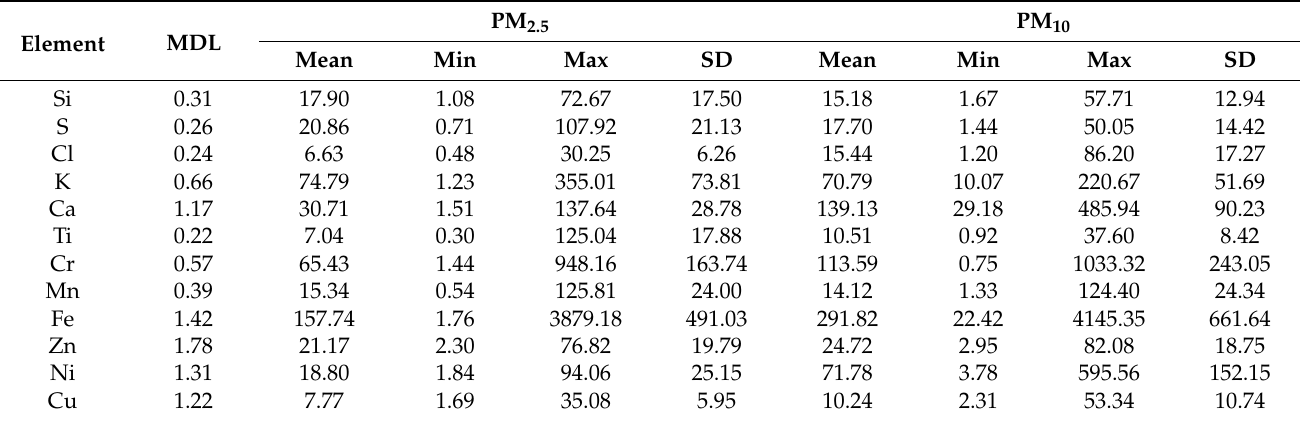
Table 5. Elemental concentrations of PM 2.5 and PM 10 in Pathum Thani Province in ng/m 3